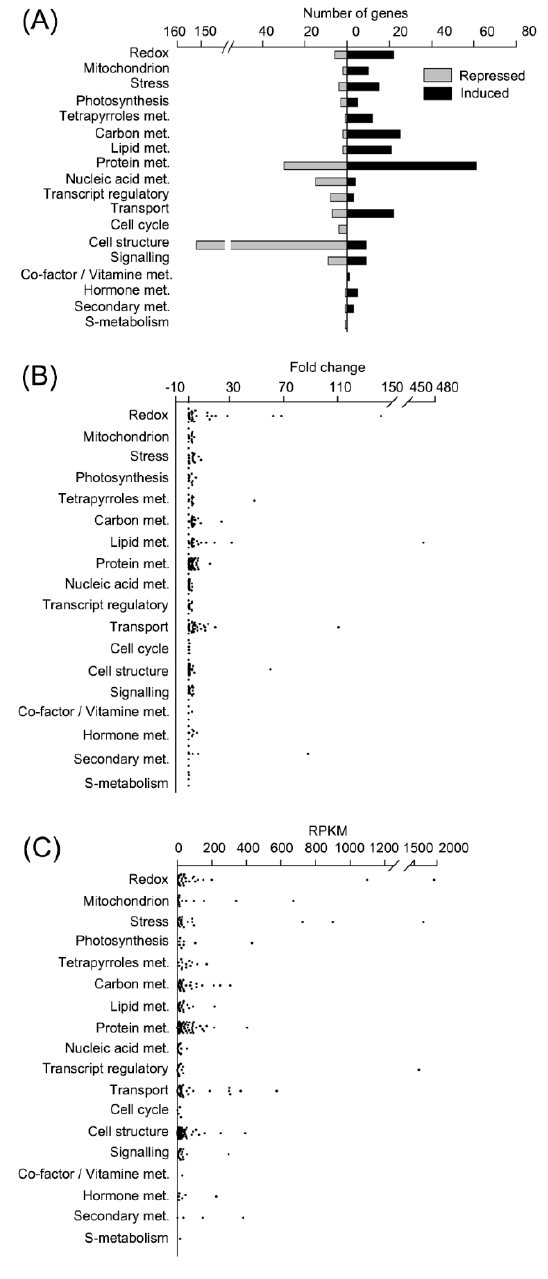
Figure 3. Functional analysis of differentially expressed genes in CC4348 after being treated with 1 μM RB for 30 min. ( A ) Functional subcategory of differentially expressed genes (DEGs) in CC4348 treated with 1 μM RB for 30 min. For clarity, only the genes with assigned functions are shown. Functional analysis of DEGs passing the criteria of fold change greater than two (up) or smaller than 0.5 (down) with FDR < 1%, based on the MapMan functional classes; met, metabolism. ( B ) The fold change of transcript abundance of DEGs in Figure 3A. The X-axis indicated the logarithm based two of the ratio of transcript abundance of genes after treated with 1 μM RB for 30 min to control in CC4348. ( C ) The relative transcript abundance of DEGs in Figure 3A. The X-axis indicated the value in unit of RPKM of transcript abundance after treated with 1 μM RB for 30 minutes in CC4348.